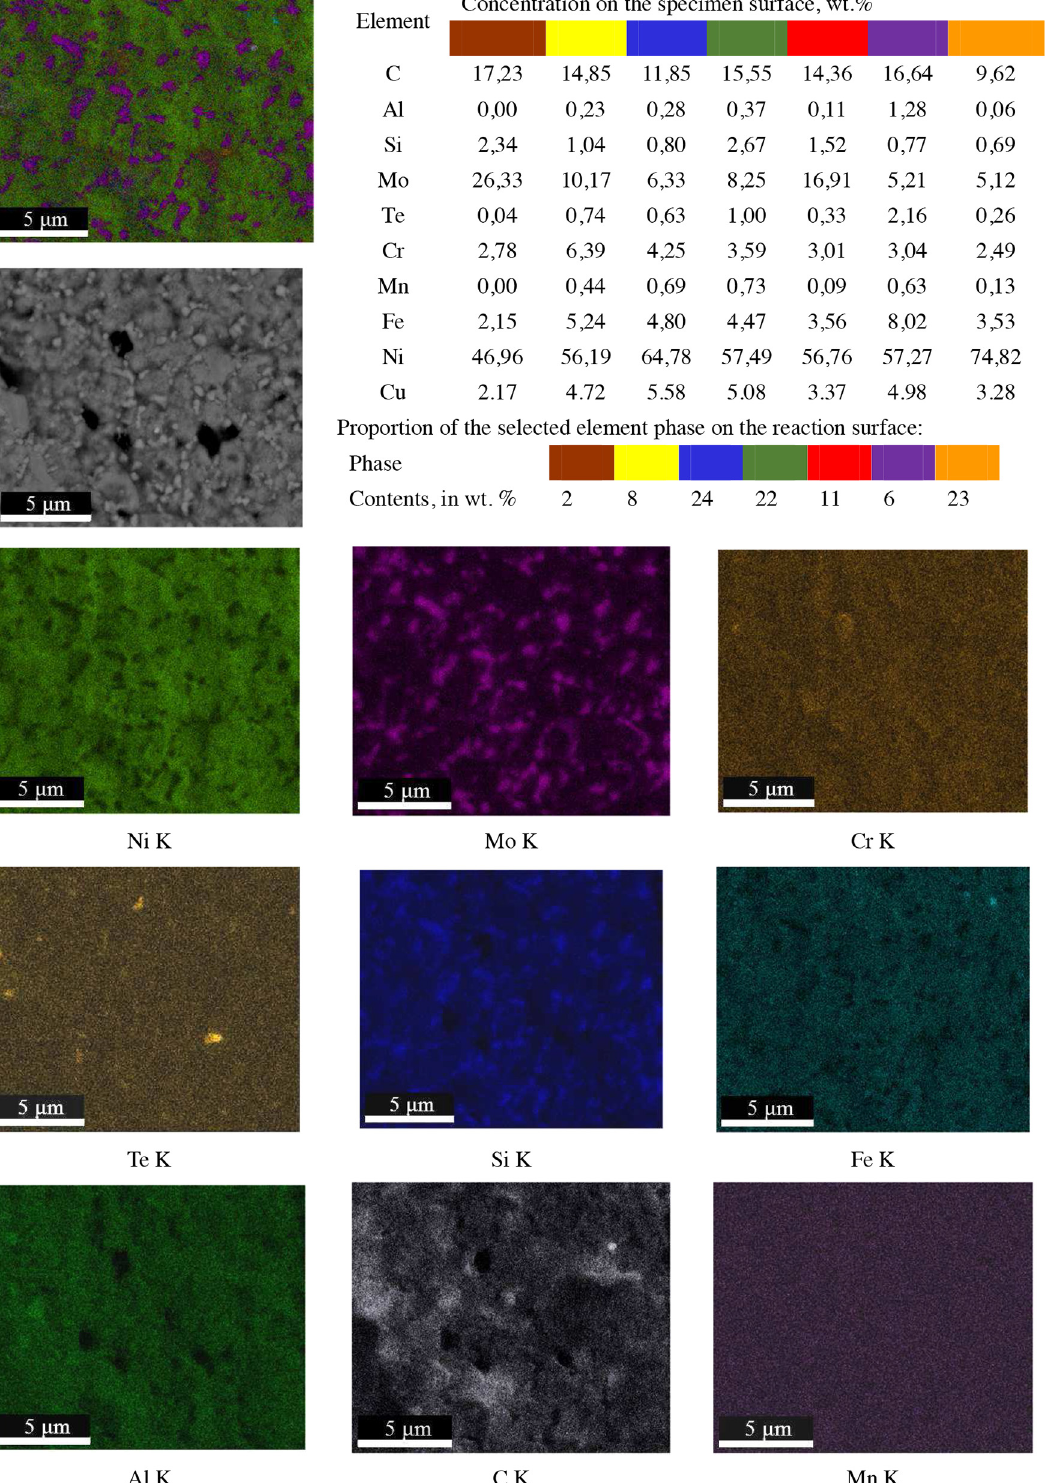
Fig. 5. MPCA metallographic structure and element composition data for different surface areas of the Hastelloy-N alloy after exposure in the fuel 71LiF-27BeF 2 -2UF 4 salt with [U(IV)]/[U(III)] ratio 42 at 760 ° C: phases of the alloy reaction surface and element content in the major